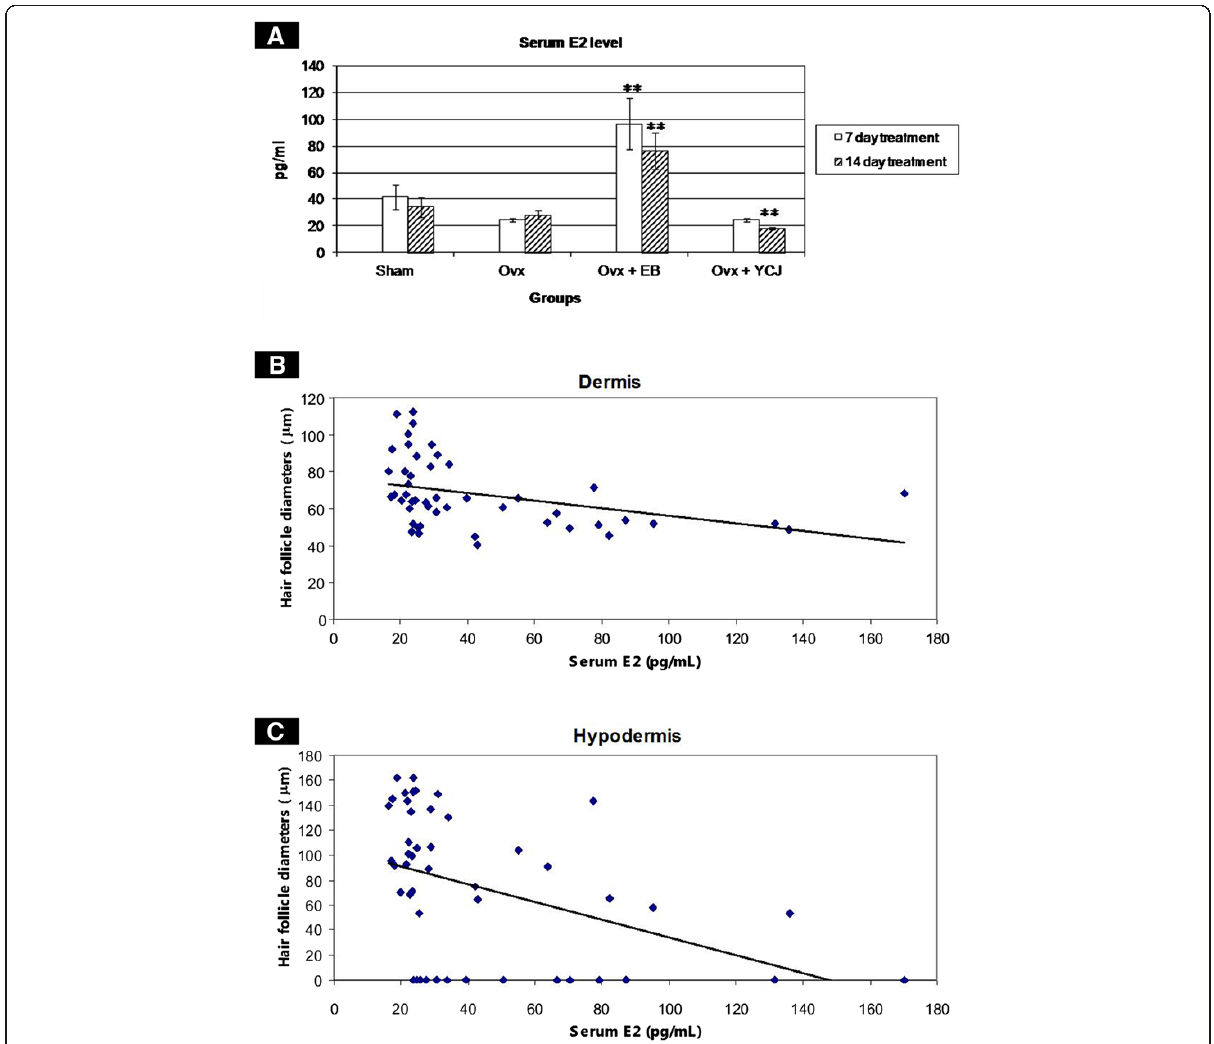
Figure 1 A. Serum estradiol ( E2 ) level ( mean ± SEM ) in the four groups examined. Ovx = ovariectomized group; Ovx + EB = ovariectomized group receiving estradiol benzoate; Ovx + YCJ = ovariectomized group receiving young coconut juice. n = 6 in each group. ** P < 0.01 compared with ovx group. B . Negative correlation between the diameter of the hair follicles in the dermis, and serum E2 level in the four groups examined. C . Negative correlation between the diameter of the hair follicles in the hypodermis and serum E2 level in the four groups